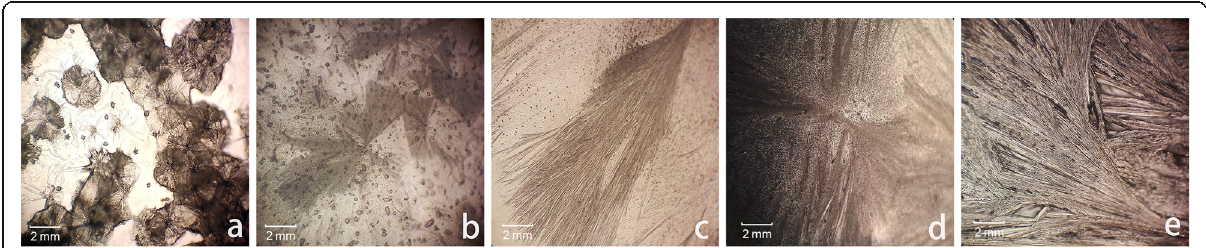
Fig. 4 Surface morphology of TBA/water co-solvent of different TBA volume percentage by optical microscope (× 100 magnification). a 40%. b 50%. c 60%. d 70%. e 80%